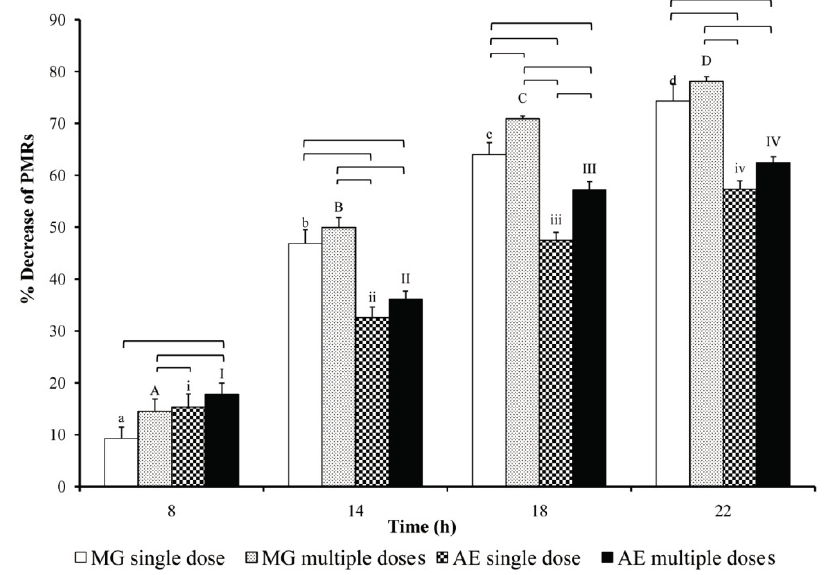
Figure 6. Percentage of the decrease in PMRs † in rats following a single and multiple oral administration of MG (40 mg/kg) and AE (100 mg/kg). † Mean ± SEM. Significance differences were considered at p < 0.05 using ANOVA followed by least significant difference test. A different sign (a lowercase letter for MG single dose; an uppercase letter for MG multiple doses; a lower case roman number for AE single dose; an upper case roman number for AE multiple doses) indicates significant difference among the same treatment. The bracket indicates a pair of data having significant